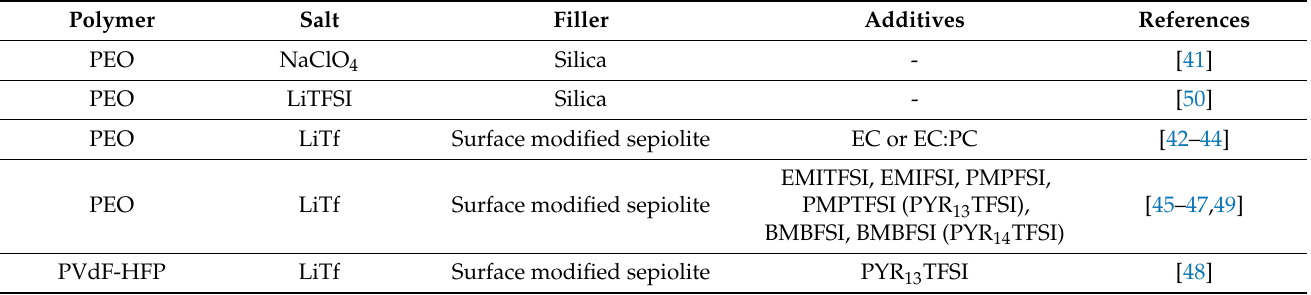
Table 1. Composition of different hybrid polymer electrolytes containing non-conductive ceramics processed by extrusion.